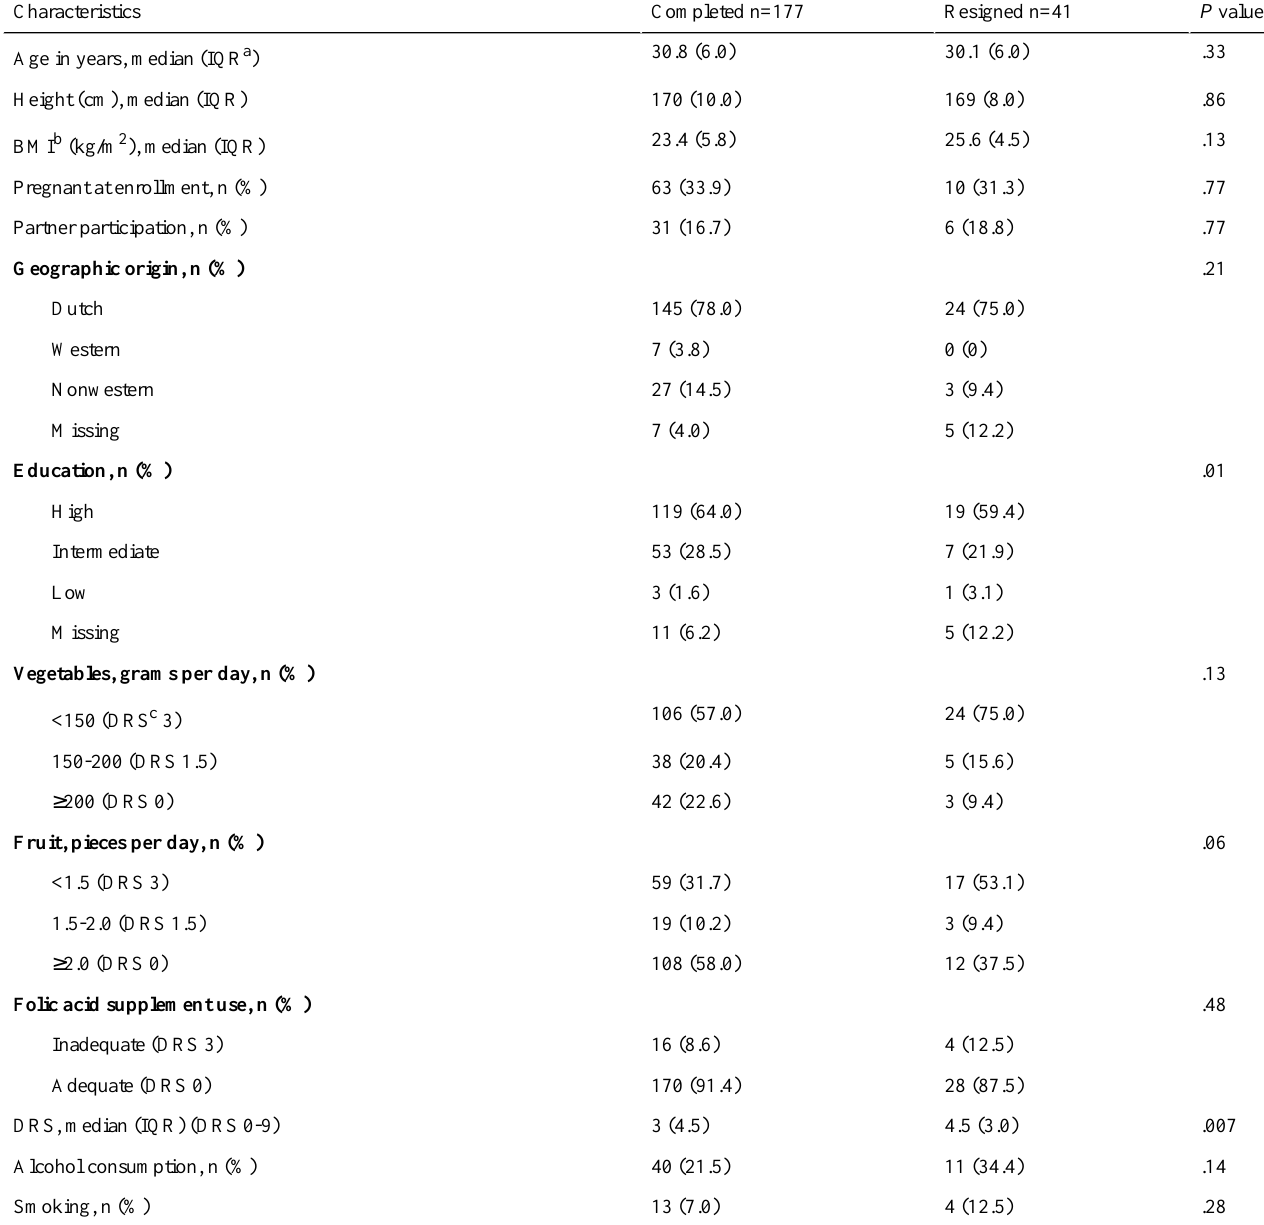
Table 2. Baseline characteristics of all women, stratified by compliance, defined as whether they completed the questionnaire at 24 weeks or resigned before this time point.